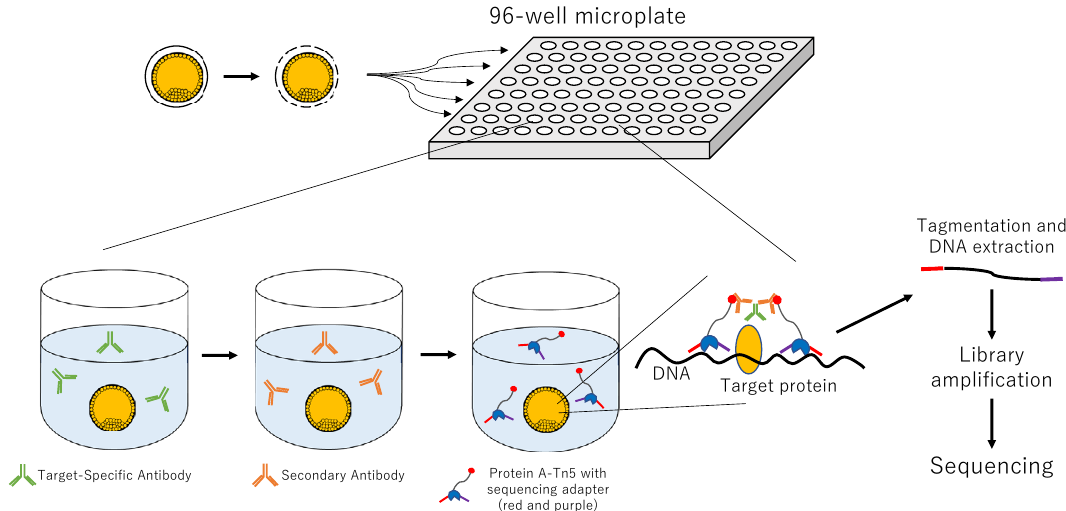
Figure 1. Schematic diagram of NON-TiE-UP CUT&Tag (NTU-CAT). See the “Methods” section for